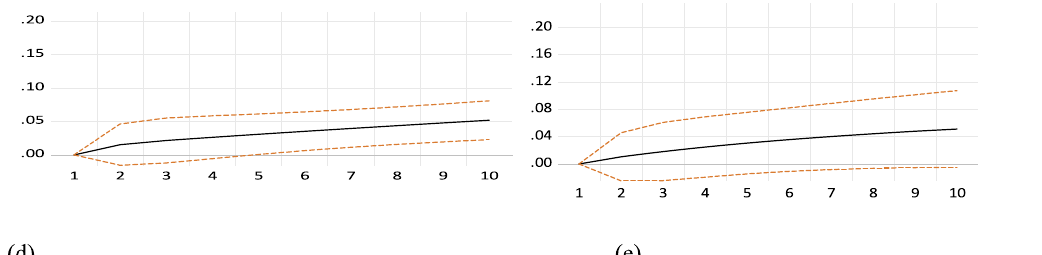
Fig. 2 IRF of LOFDIS to explanatory variables. This fi gure shows the response of LOFDIS to a unit shock in explanatory variables. a Response of LOFDIS to OLDFIS. b Response of LOFDIS to LINDEX. c Response of LOFDIS to LPCI. d Response of LOFDIS to TECHNO. e Response of LOFDI to